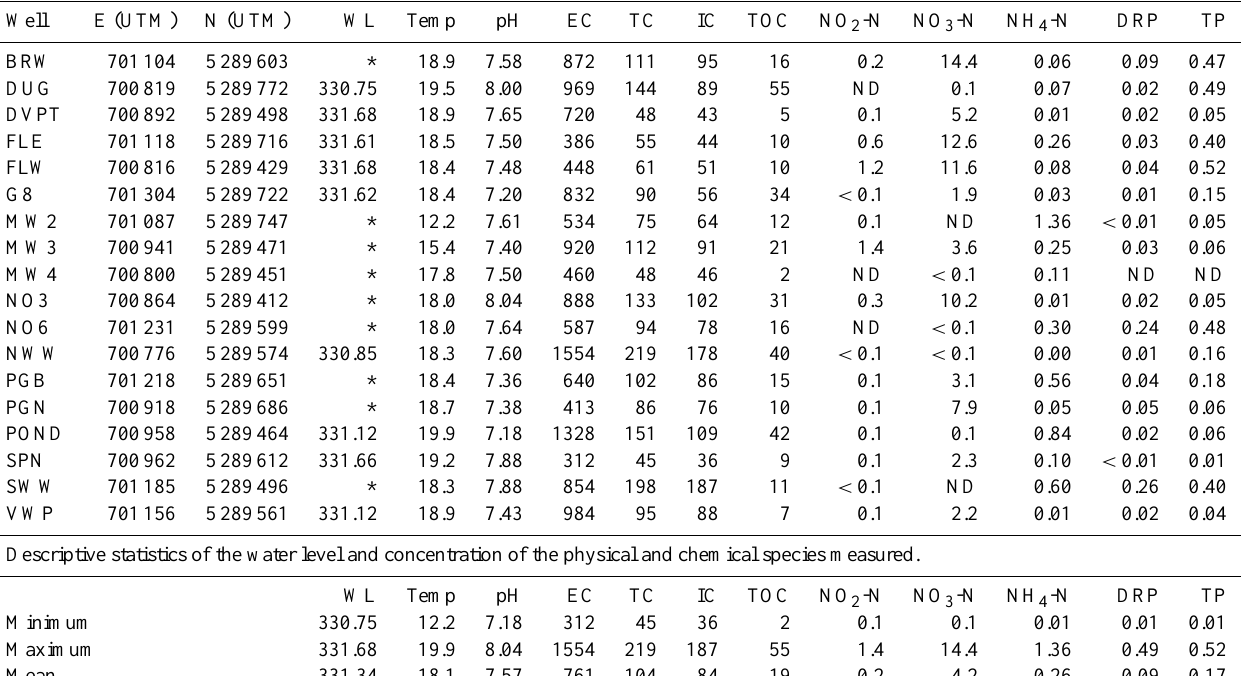
Table 1. Location, water level, and concentration of the physical and chemical species of the water at each sample location, along with descriptive